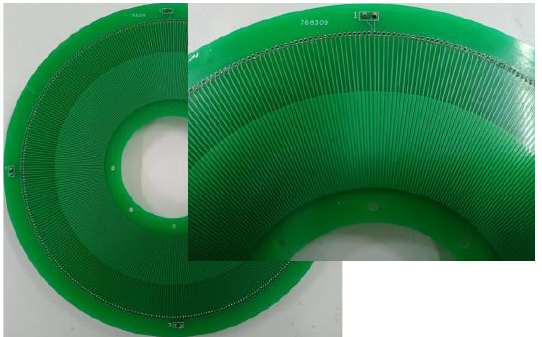
Figure 10. Special rotor for Extracting capacitive potential.